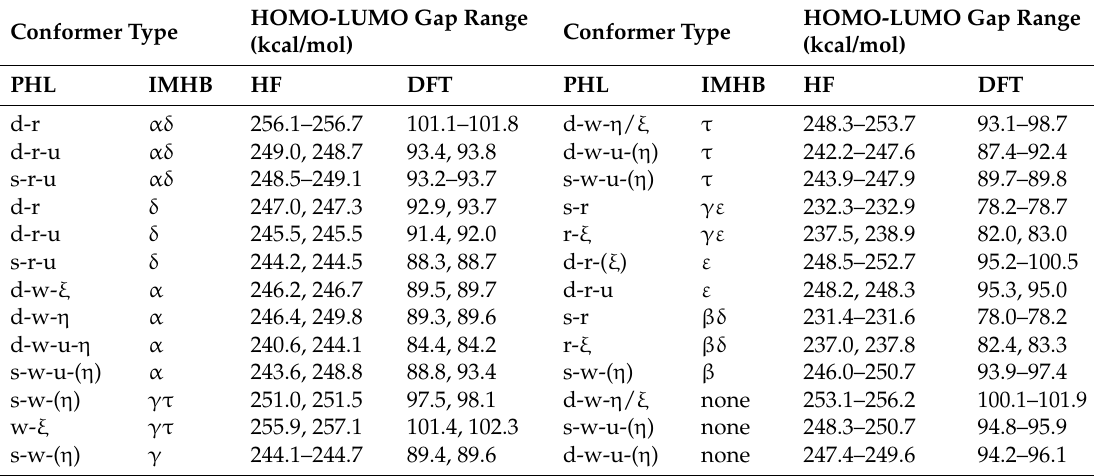
Table 8. Ranges of the HOMO-LUMO energy difference (kcal/mol) of the calculated conformers of arzanol. HF/6-31G(d,p) and DFT/B3LYP/6-31+G(d,p) results in vacuo, respectively denoted as